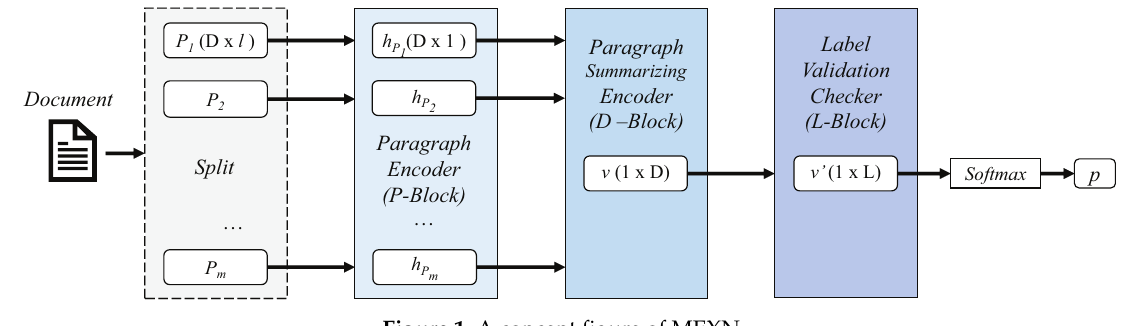
Figure 1. A concept figure of